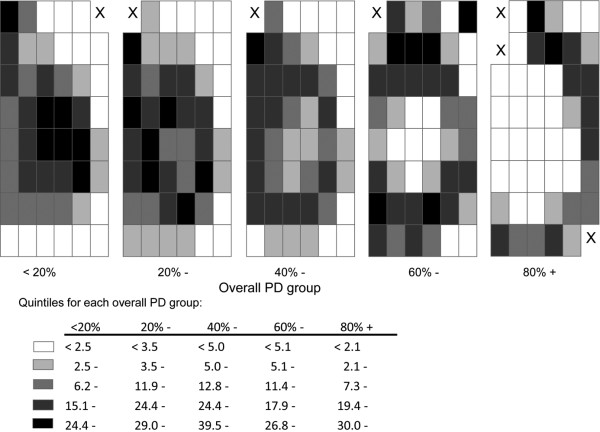
Between-woman variability in regional percent density, by level of overall percent density. For each region, between-woman variability in regional percent density (PD) was estimated by the standard deviation (SD) of the PDs for all participants in each overall PD group. X, region where fewer than two women contributed to the analysis and hence the SD could not be estimated.